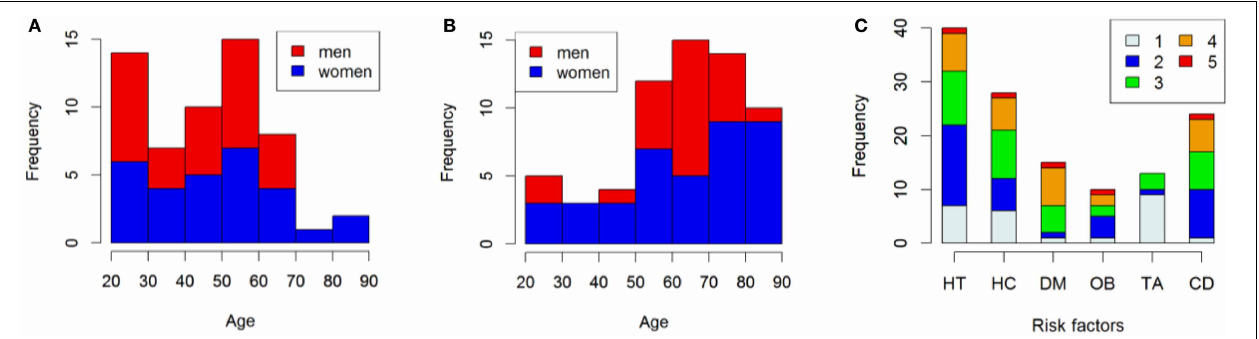
FIGURE 2 | (A) Distribution of age and gender for the NRF subsample. (B) Idem, but for the WRF subsample. (C) Distribution of the risk factors in the WRF subsample. The height of the bars shows the overall number of subjects with each risk factor. As subjects may have more than one risk factor simultaneously, the bars are separated into colored sections